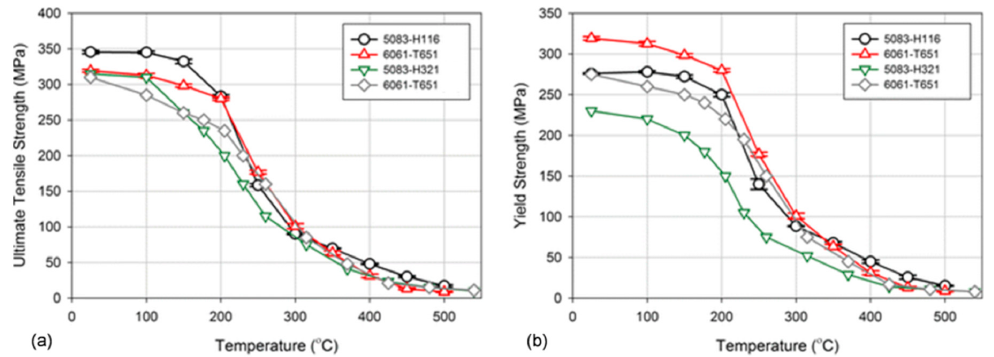
Figure 33. Degradation of tensile properties of 5083 − H116 and 6061 − T651 alloys during exposures to heat, expressed through ultimate tensile strength ( a ) and yield stress ( b ) [10].